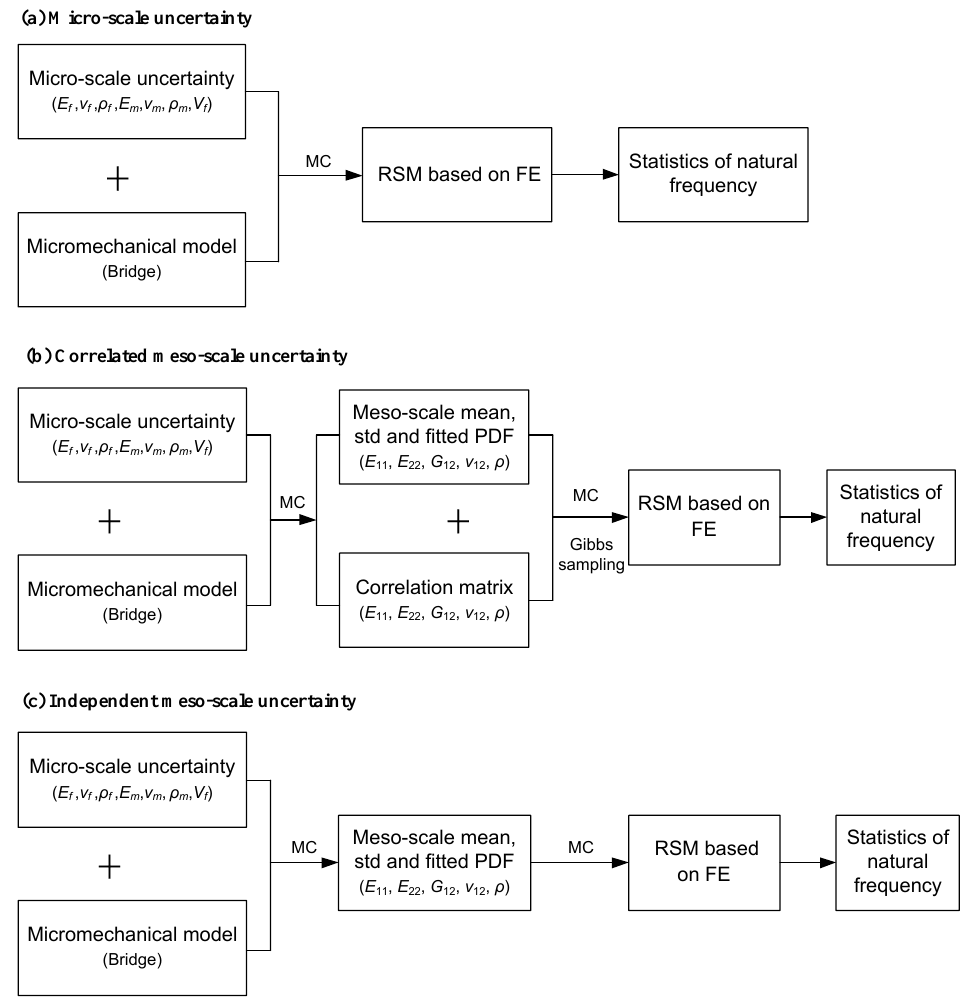
Figure 1. Flowchart of calculation of natural frequency statistics by different uncertainty consideration.